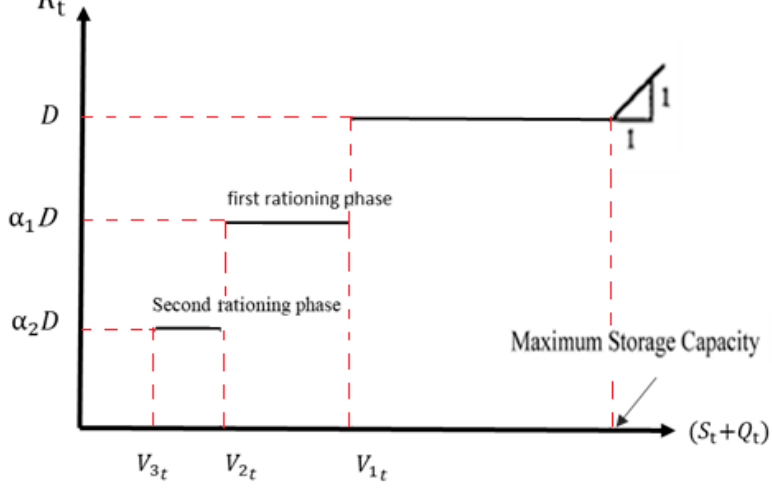
Figure 1. The discrete hedging method.